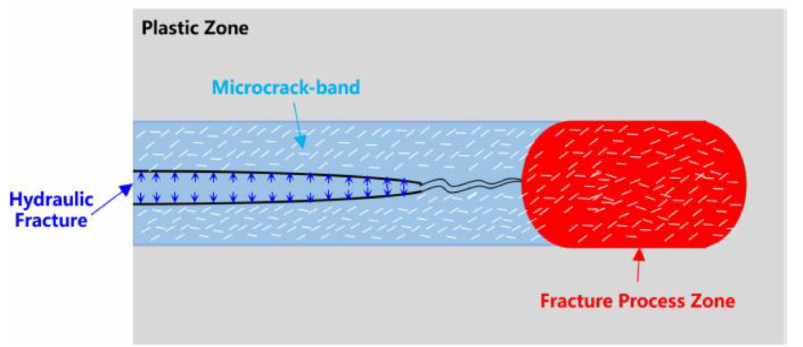
Figure 11. The schematic diagram of nonlinear zones caused by the hydraulic fracturing. Reprinted from Ref. [230]. At present, only a type I fracture is considered by the apparent fracture toughness models, and the CZM model is only applicable to the pre-specified propagation path. By using the global CZM model [237], the propagation path can be determined according to the propagation criterion (Figure 12). In this way, the interaction between the hydraulic fracturing fracture and the natural fracture network can be simulated [238,239]. However, the fracture propagation path is only limited to the grid boundary through this method. In order not to impose artificial restrictions on the propagation path of fractures, the XFEM